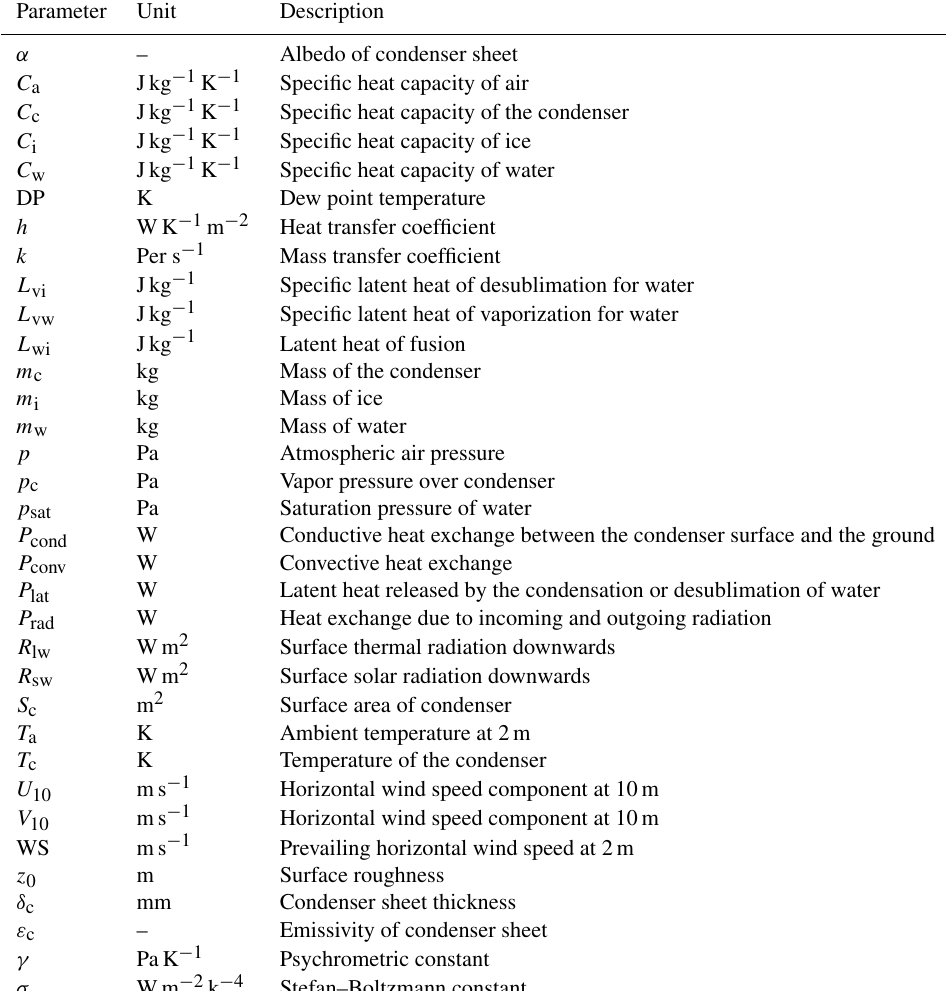
Table 3. A list of nomenclature.